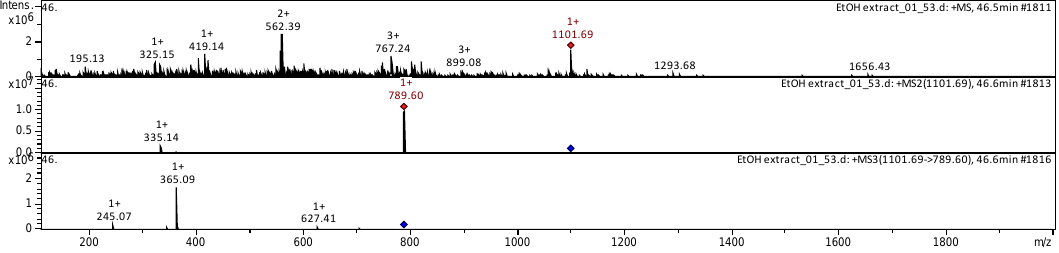
Figure 9. Structure of ginsenoside Rb 2 from wild ginseng (Russia).